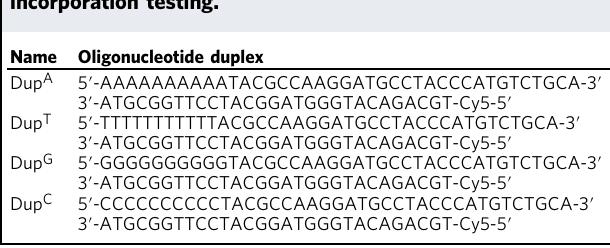
Table 1 Characteristics of dd ON NTP after CuAAC click reactions.